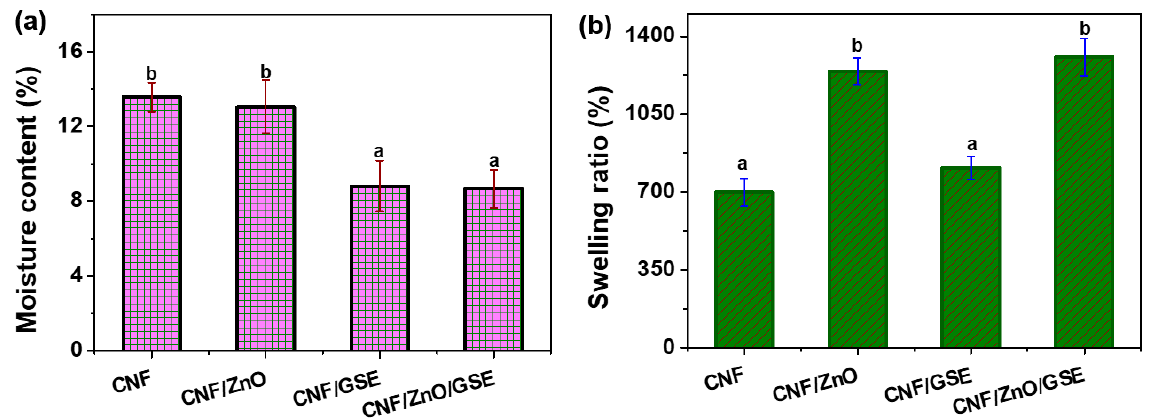
Figure 5. Moisture content ( a ) and swelling ratio ( b ) of the CNF/ZnO/GSE films. Data with the same superscript letter within the same column are not significantly ( p > 0.05) different from Duncan’s multiple range tests.